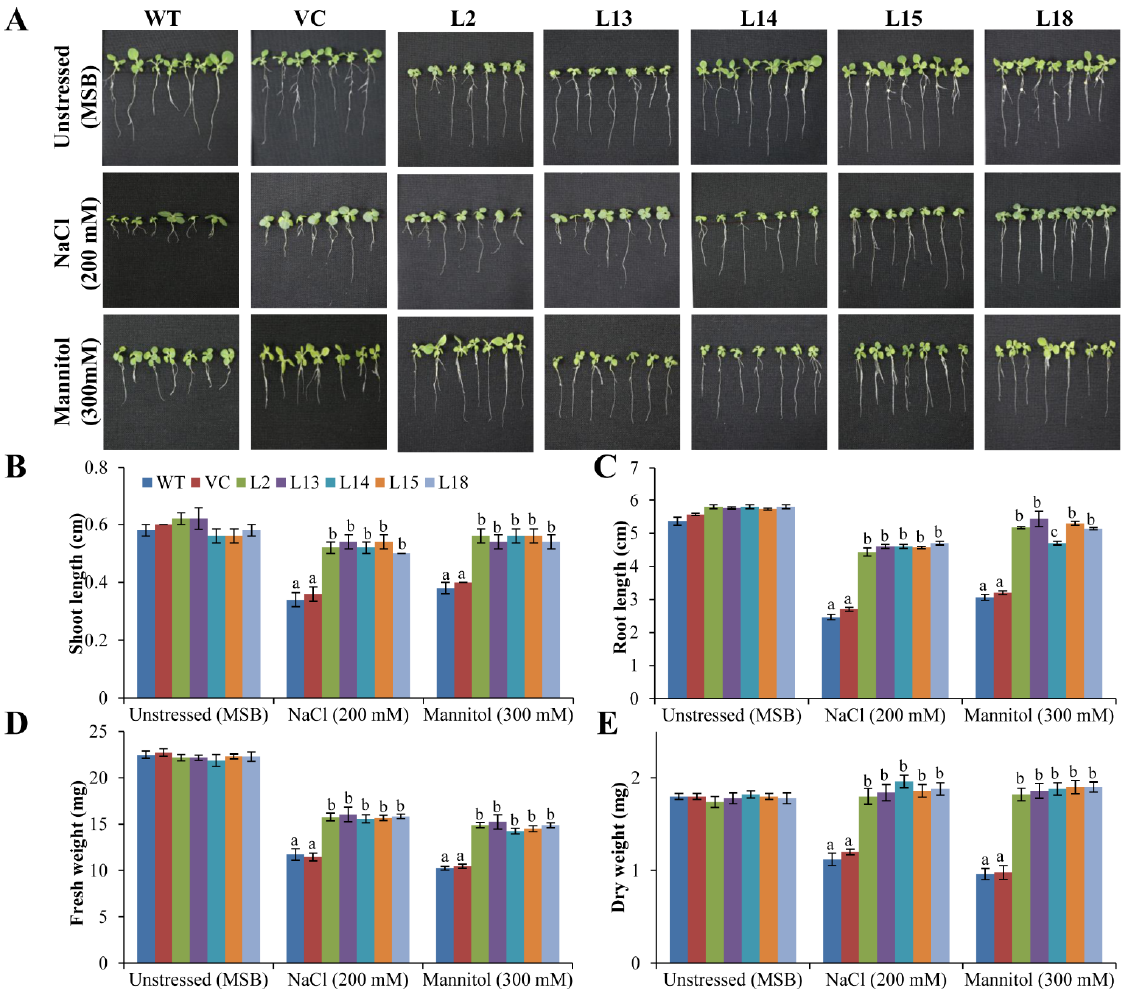
Figure 3. Plant growth analysis under abiotic stress conditions. Comparative analyses of ( A ) mor- phology, ( B ) shoot length, ( C ) root length, ( D ) fresh weight, and ( E ) dry weight of transgenic lines (L2, L13, L14, L15, and L18) and control plants (WT and CV) grown under unstressed (MSB), salt (200 mM NaCl), and drought/osmotic (300 mM mannitol) stress conditions. Data shown as mean ± SE and values shown with different letters are significant at p < 0.05.